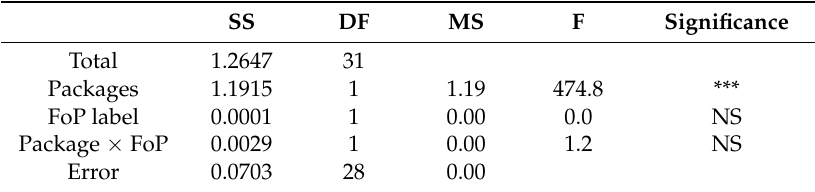
Table 3. Analysis of variance Christchurch, stores as replications.